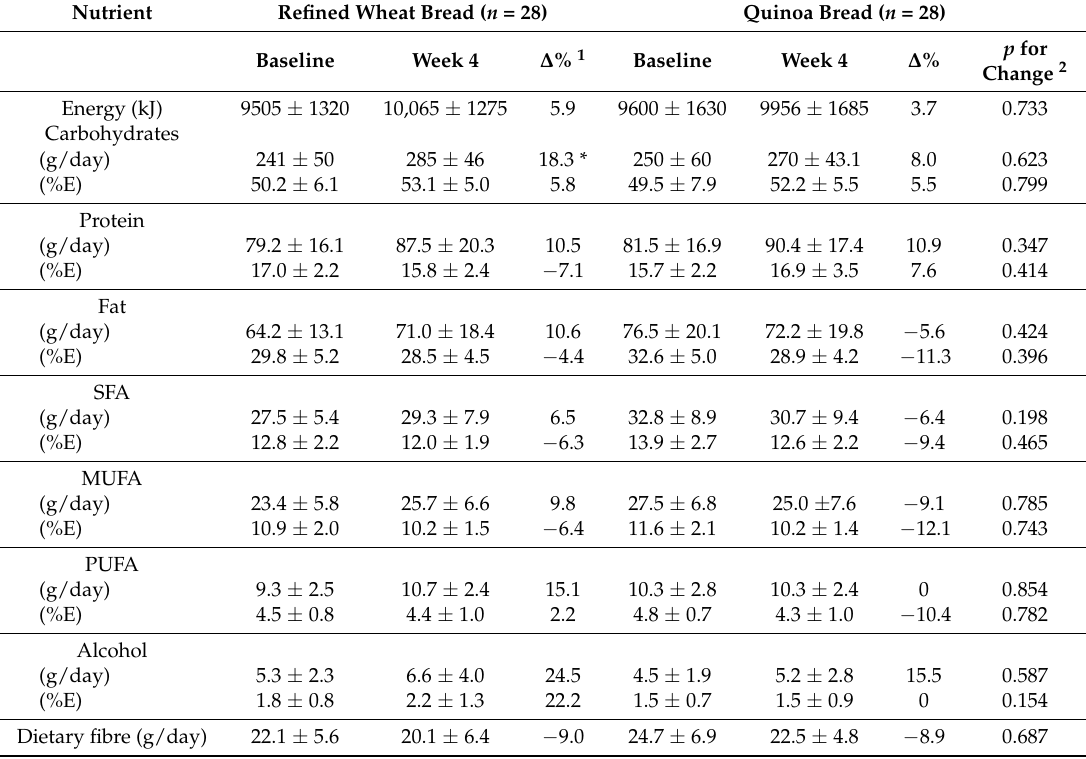
Table 4. Mean daily intake of nutrients before and at the end of each treatment arm in all subjects, mean values ±